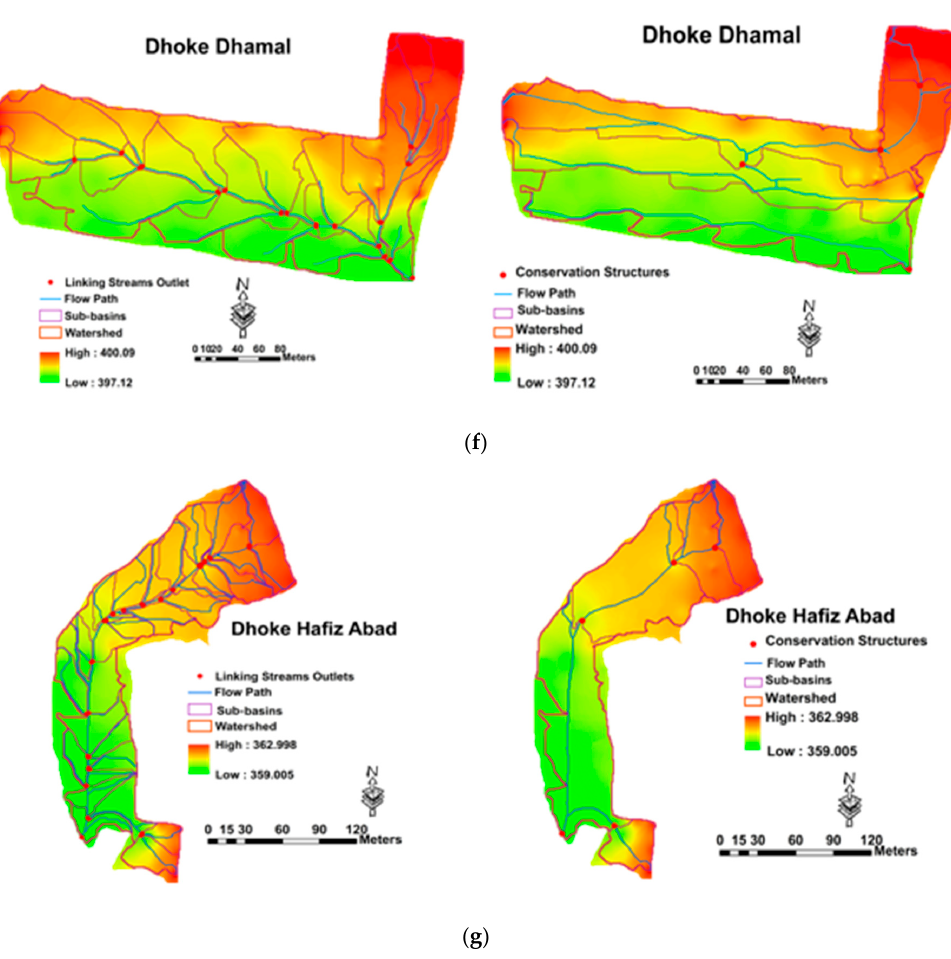
Figure 4. Topographic maps of selected small watersheds in the Chakwal and Attock Districts for model application: ( a ) Khokar Bala watershed, ( b ) Khandoya watershed, ( c ) Khaliq Gully watershed, ( d ) Ashraf Gully watershed, ( e ) Chak Khushi watershed, ( f ) Dhoke Dhamal watershed, and ( g ) Dhoke Hafiz Abad watershed.